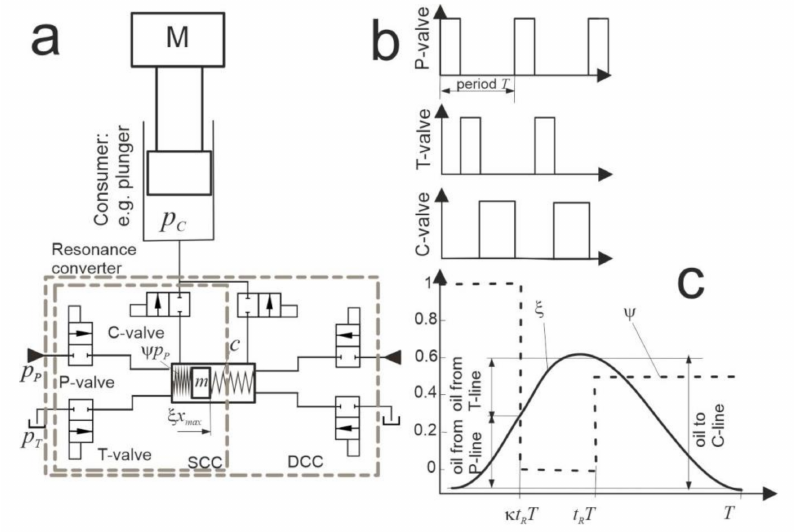
Figure 1. The hydraulic resonance converter: concept ( a ), switching diagram ( b ), and typical response ( c ). SCC: single chamber converter; DCC: double chamber converter.